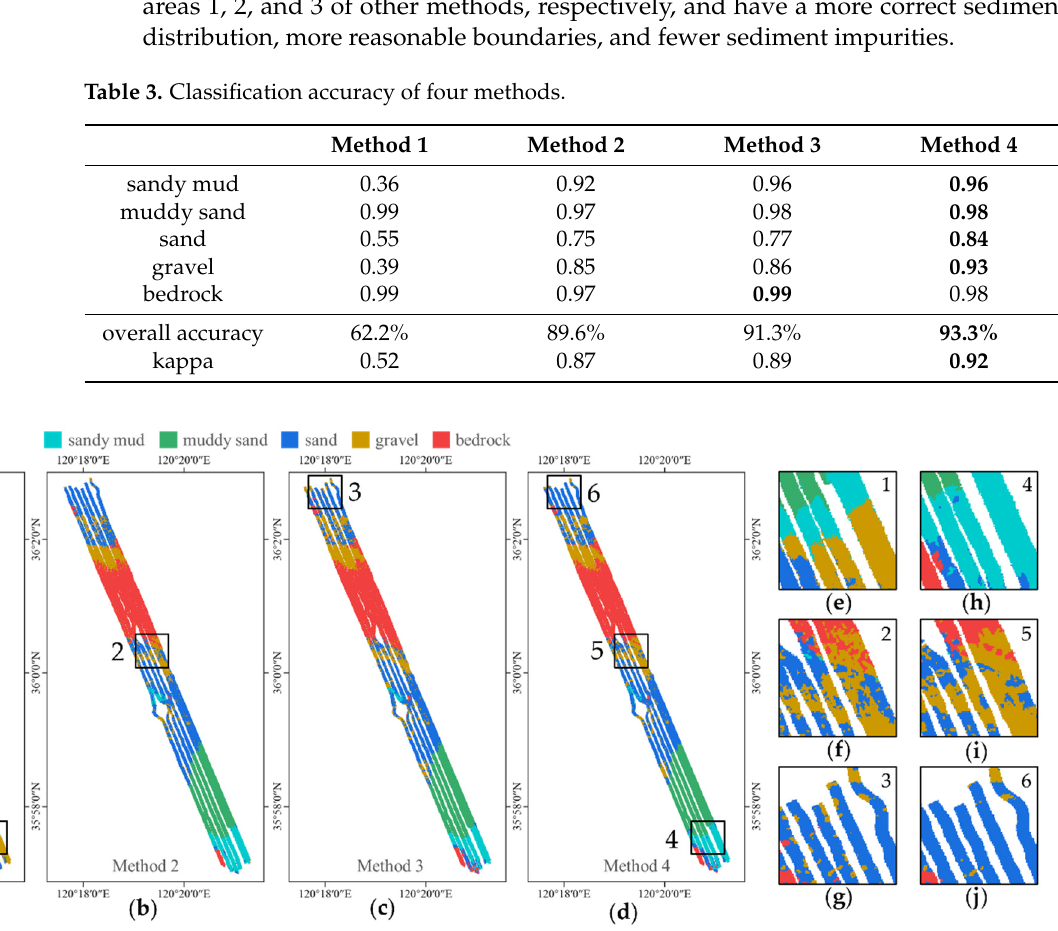
Figure 11. The sediment maps of four methods. ( a – d ) are the sediment maps of Method 1, Method 2, Method 3, our method, respectively; ( e – j ) are the details of areas 1-6 respectively. Table 3. Classification accuracy of four methods.